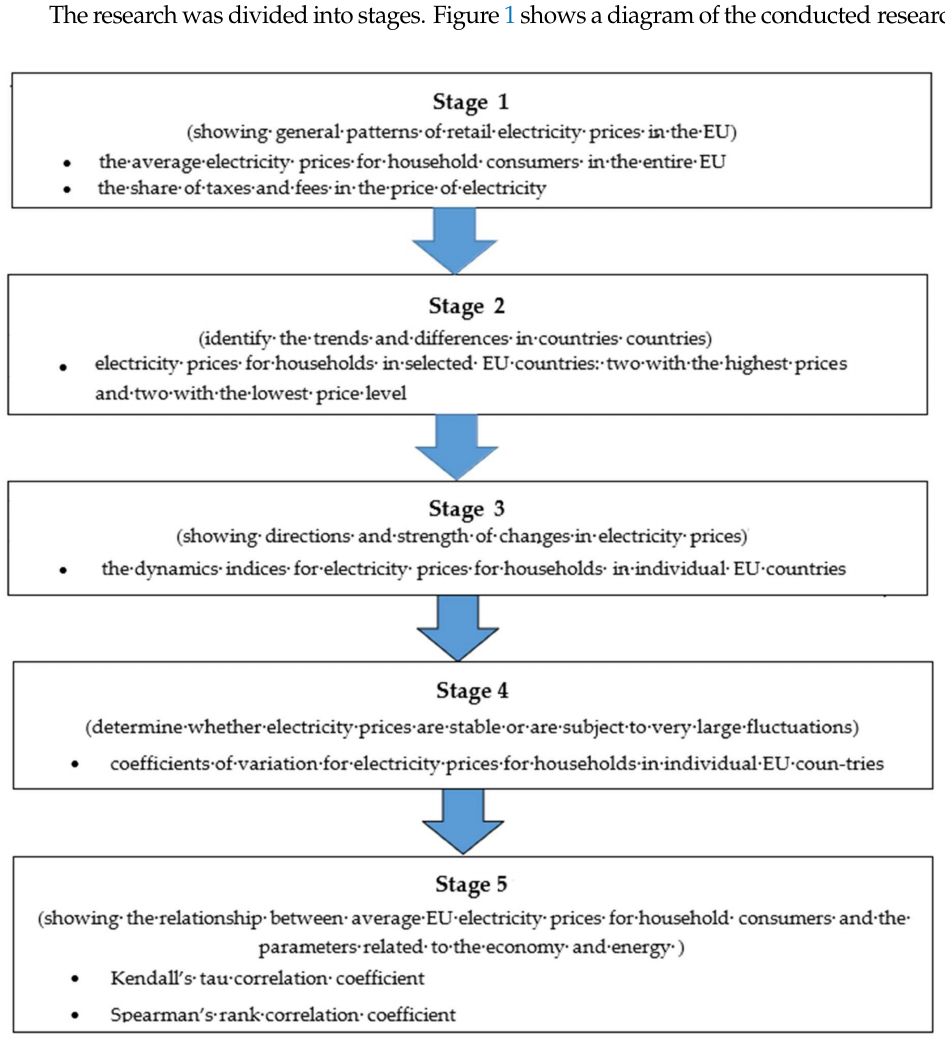
Figure 1. Diagram of the conducted